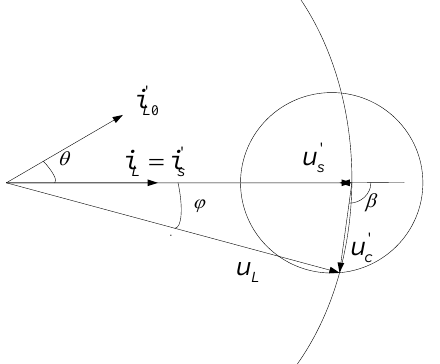
Figure 6. Schematic diagram of the voltage vector at the secondary side.